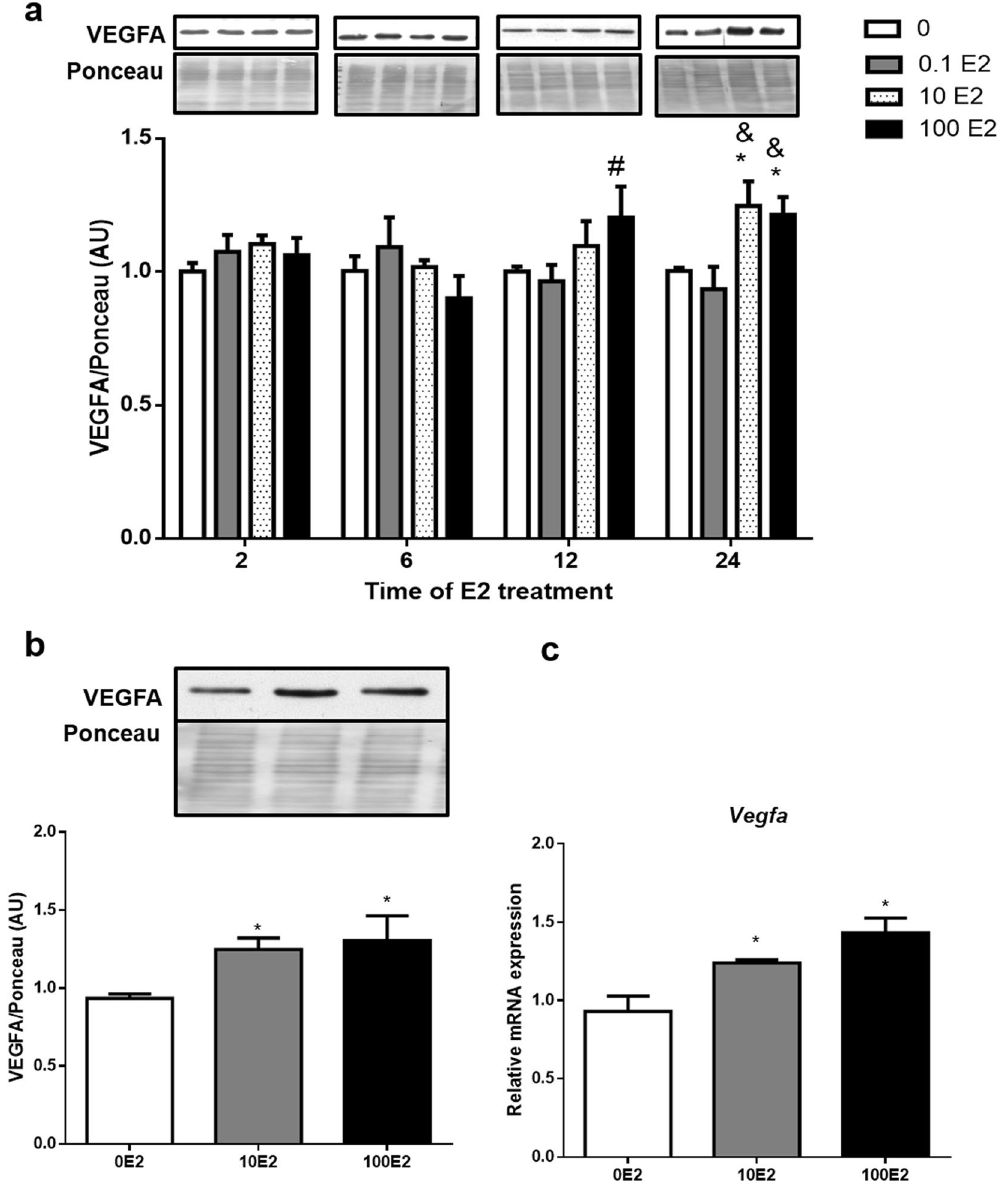
Figure 1. E2 effects on VEGFA mRNA and protein expression: 3T3-L1 adipocytes were treated for 2, 6, 12 and 24 hours with 0.1, 10 nM and 100 nM of E2. Cells treated only with vehicle were used as control (0E2). VEGFA protein ( a and b ) and mRNA ( c ) were analyzed by Western blotting and qPCR, respectively. In panel b, are shown the graph with the results referent to the treatments with 10 and 100nM of E2 for 24 hours with a representative autoradiogram. Full-length blots of the cropped image are presented in Supplementary Figure S1. Data on the graphs represent mean ± SEM of 5 to 8 samples. * P < 0.05 vs 0E2, # P < 0.05 vs 0.1E2, & P < 0.05 vs 0.1 E2 in the same